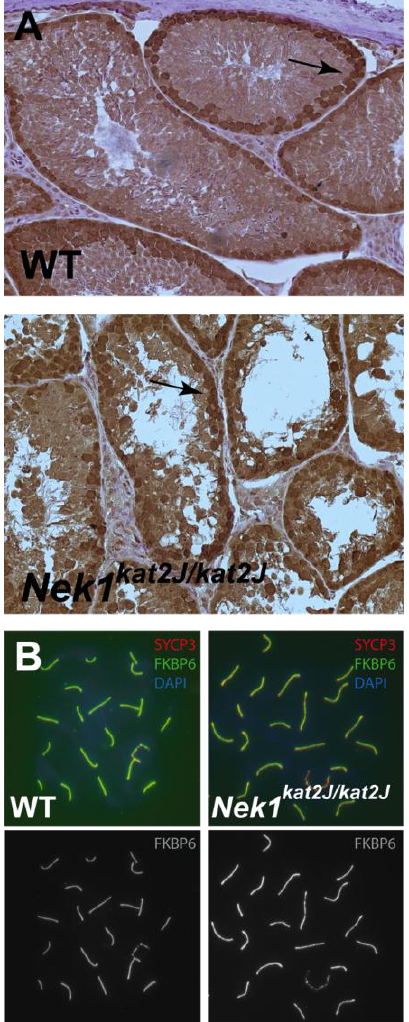
Figure 6. NEK1 protein acts later than FKBP6 in prophase I cells. ( A ) Wild type and Nek1 kat2J/kat2J testes sections were stained with an antibody to FKBP6 (brown stain)